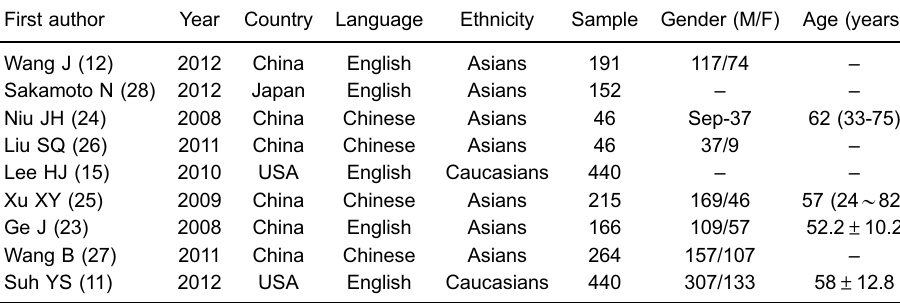
Table 1. Baseline characteristics of the nine included